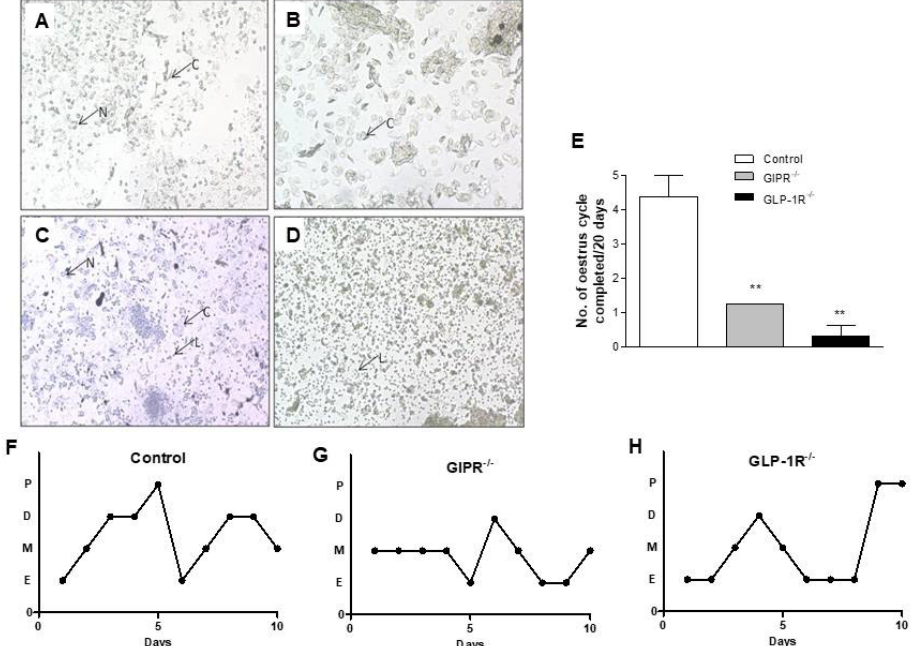
Figure 3. Menstrual stages in normal C57BL/6 mice and effects of GIP- and GLP-1-receptor knockout on estrous cycle. Representative photomicrographs of unstained vaginal smear from control C57BL/6 mice at proestrus (( A ), consisting of mostly nucleated epithelial cells), estrus (( B ), with predominantly anucleated cornified cells), metestrus (( C ), consisting of leukocytes, cornified and nucleated epithelial cells) and diestrus (( D ), containing mostly leucocytes). N = Nucleated epithelial cells, C = Cornified epithelial cells and L = Leucocytes. ( E ) Number of estrous cycles completed in 20 consecutive days. Graphic representation of different stages of first ten days of estrous cycle monitoring of individual ( F ) control, ( G ) GIPR −/− and ( H ) GLP-1R −/− mice. Values are mean ± SEM with n = 4. ** p < 0.01 compared to control.